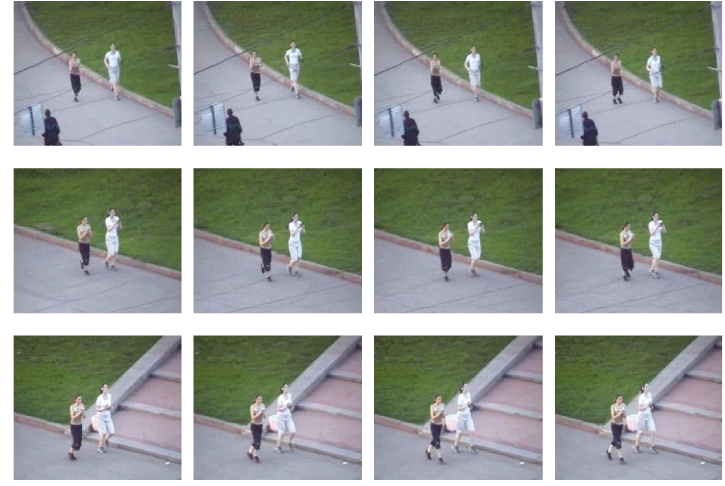
Figure 2: Video fragments of “ Jogging. ”